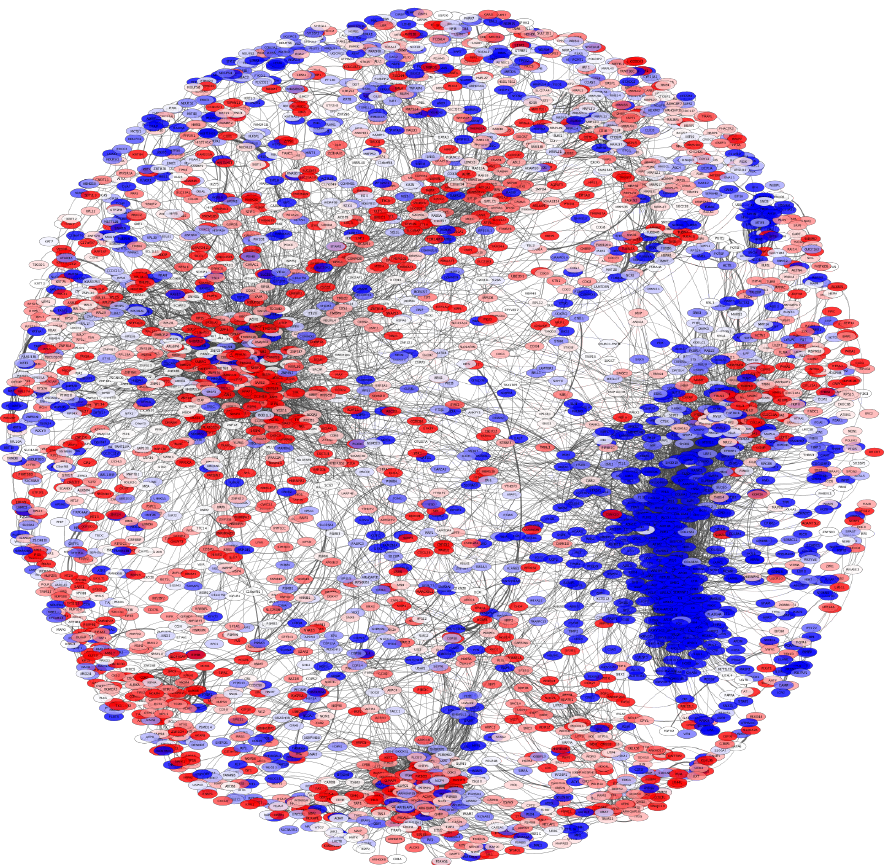
Figure 6. Protein co-expression network. This network shows the pGenes in the giant component of the network. The color of nodes represents the log2 fold-change expression level of genes inferred from the protein expression of tumor samples compared to healthy tissue samples for shared and unshared peptides. Overexpression is depicted in red, while blue nodes show underexpression. Notice the distribution of nodes biased to the differential expression